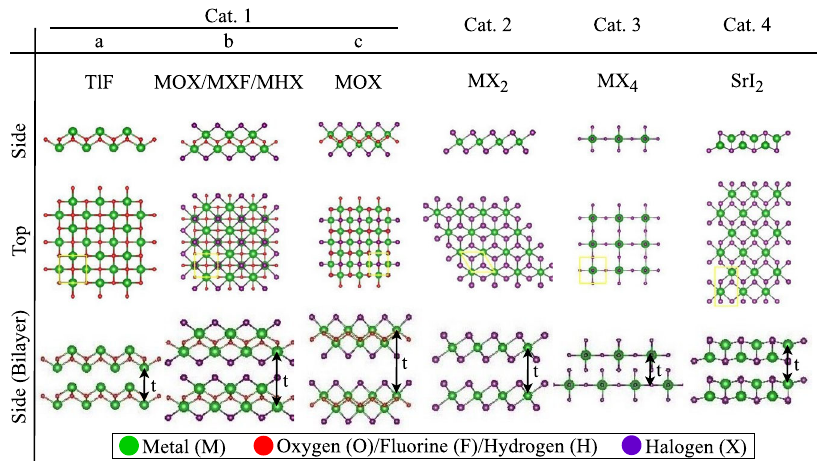
Fig. 1 The structure of 32 vdW materials. Side and top views of the monolayer structures are shown, where the yellow squares represent the computational unit cells. Side views of the bilayer structures are also presented, showing the A – A and A – B stacking con fi gurations. The measurement of the thickness of the monolayers ( t ) is indicated. Category 1 contains three similar structures, further divided in subcategories a, b and